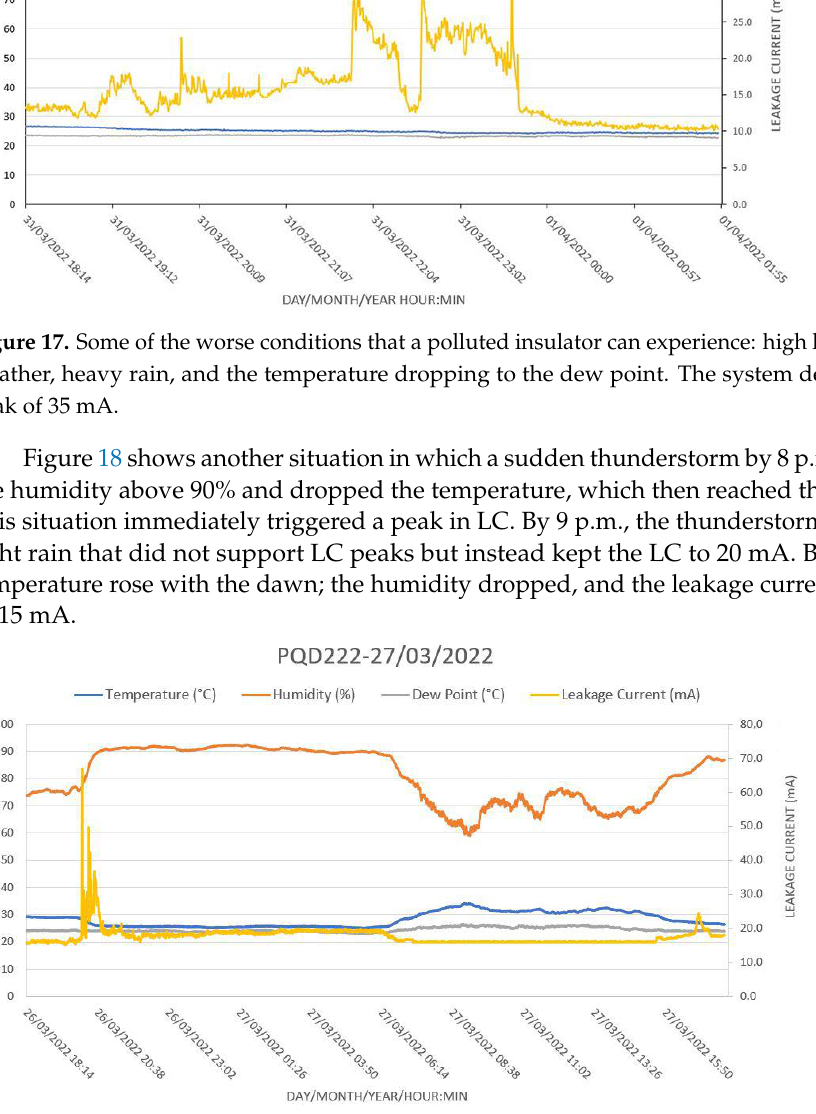
Figure 18. A sudden thunderstorm by 8 p.m. increased the humidity above 90% and dropped the temperature, which reached the dew point, triggering a peak of LC to 70 mA. By 9 p.m., the thunderstorm had changed to light rain, keeping the LC at 20 mA. By 6 a.m., at dawn, the temperature rose, the humidity dropped, and the leakage current decreased to 15 mA.